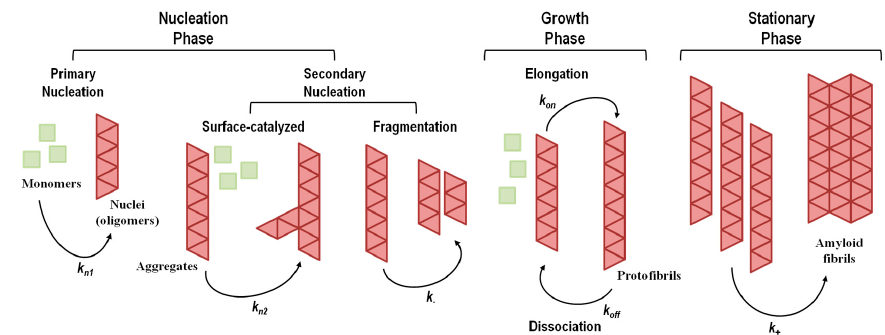
Figure 4. Representative general model for amyloid fibril formation by nucleation-dependent mechanisms (including primary and secondary nucleation) and nucleation-independent mechanisms (absence of nucleation). k n1 , k n2 , k − , k on , k o ff , and k + represent rate constants. The stationary phase involves the assembly of protofibrils into mature amyloid fibrils with di ff erent morphological structures and a high level of polymorphism. Adapted from reference